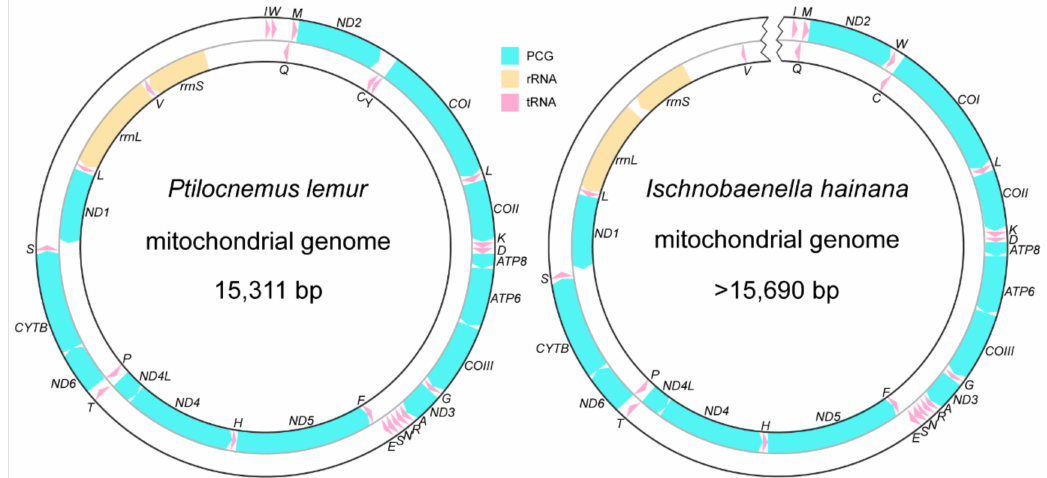
Figure 1. Circular maps of P. lemur and I. hainana mitogenomes. The transcriptional direction is denoted by arrows. The evolutionary rate of 13 mitochondrial PCGs in Reduviidae was evaluated with the ka/ks ratio (Figure S1). All the average ka/ks ratios for each PCG are lower than 1—ranging from 0.087 ( COI ) to 0.805 ( ATP8 )—indicating that these PCGs evolved